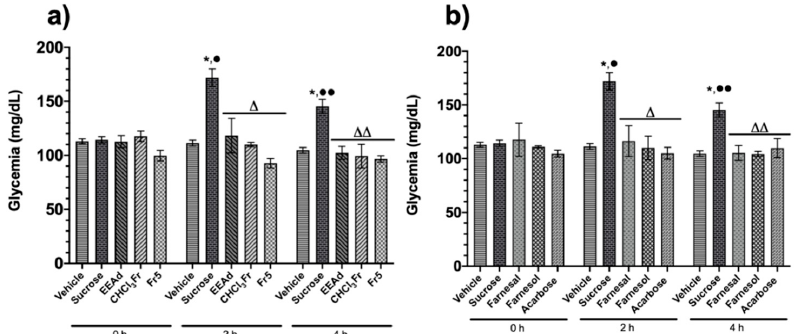
Figure 1. E ff ect of products isolated from Annona diversifolia and acarbose on the oral sucrose tolerance test (OSTT). ( a ) Groups treated with vehicle, sucrose (3 g / kg), EEAd, CHCl 3 Fr (200 mg / kg), and Fr5 (50 mg / kg). ( b ) Groups treated with vehicle, sucrose (3 g / kg), farnesal, farnesol, and acarbose (50 mg / kg). Data are expressed as means ± SEM, n = 6; * p < 0.05 vs. initial values; • p < 0.05 vs. vehicle for 2 h; •• p < 0.05 vs. vehicle for 4 h; ∆ p < 0.05 vs. sucrose for 2 h; ∆∆ p < 0.05 vs. sucrose for 4